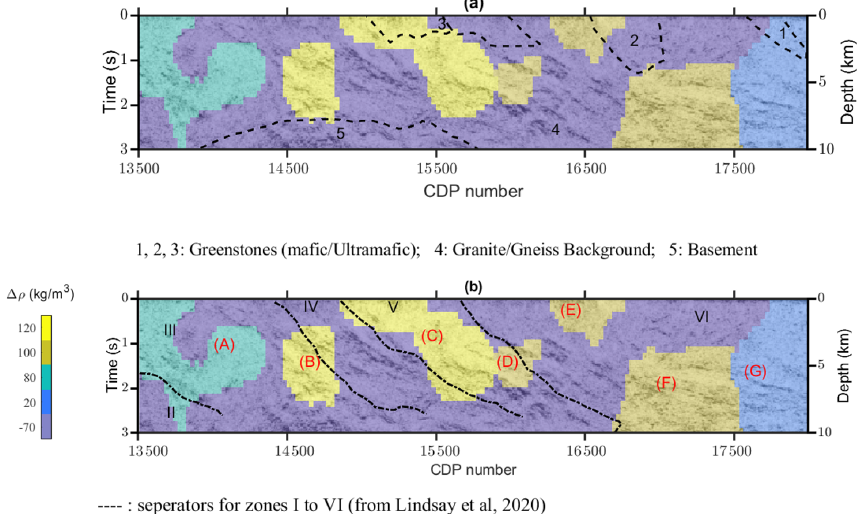
Figure 15. (a) Overlaid final inverted model from the constrained 3D level set inversion with the seismic image and existing primary interpretations in Goleby et al. (2004) (zones 1 to 5). (b) Overlaid model with integrated interpretations based on seismic characters in Lindsay et al. (2020) (zones I to VI). Notation in red (from A to G) indicates distinct units in the resulting model from the constrained